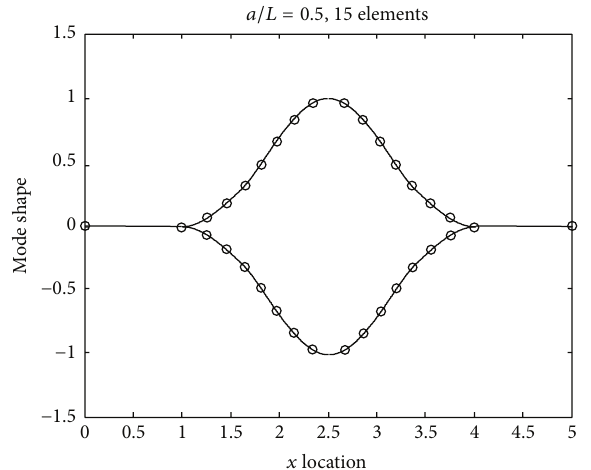
Figure 6: The inadmissible mode; interpenetration of equithickness topandbottombeams.Whilemathematicallypossible,thissituation would not be encountered in practical applications; 60% of span, midplane delamination, 15-element FEM model within the delami- nation zone.